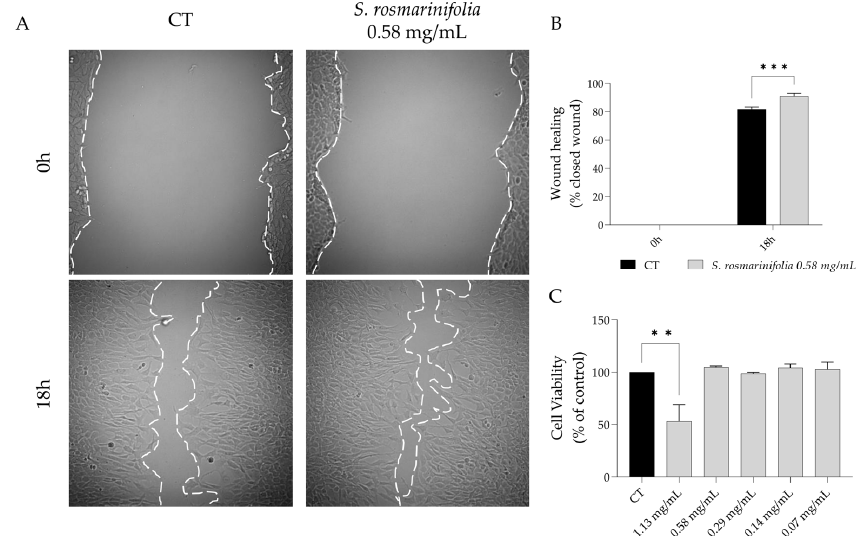
Figure 7. Santolina rosmarinifolia promoted NIH 3T3 fibroblasts migration using the scratch wound healing assay. ( A ) Representative bright-field images of NIH 3T3 fibroblasts 0 and 18h post-scratch. White line limits wound edges. ( B ) Percentage of closed wound at 0h and 18h post-scratch. ( C ) Cell viability of NIH 3T3 fibroblasts after 24h of treatment with the essential oil. Results show the mean ± SEM of three independent assays made in duplicate. ** p < 0.01 and *** p < 0.001 when compared to control (CT).